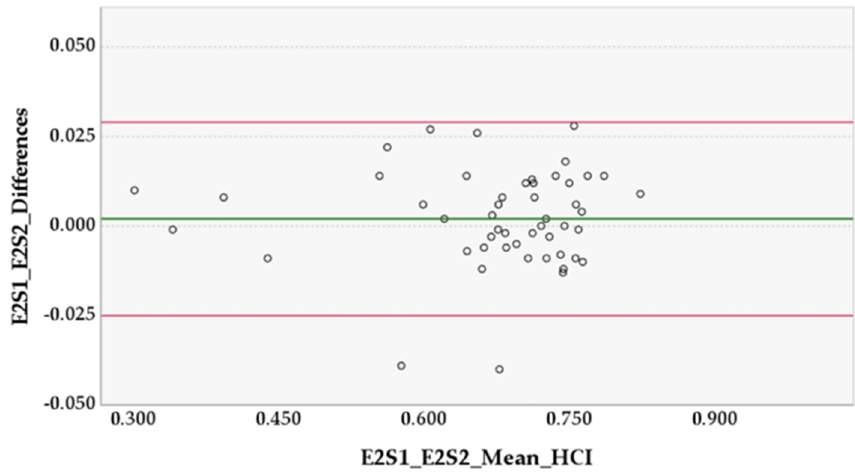
Figure 4. Differences between Examiner 2, Sessions 1 and 2 (E2S1 and E2S2). The horizontal lines represent the mean of the differences (0.002) and the upper and lower 95% limits of agreement, approximately 0.029 and − 0.025, respectively.